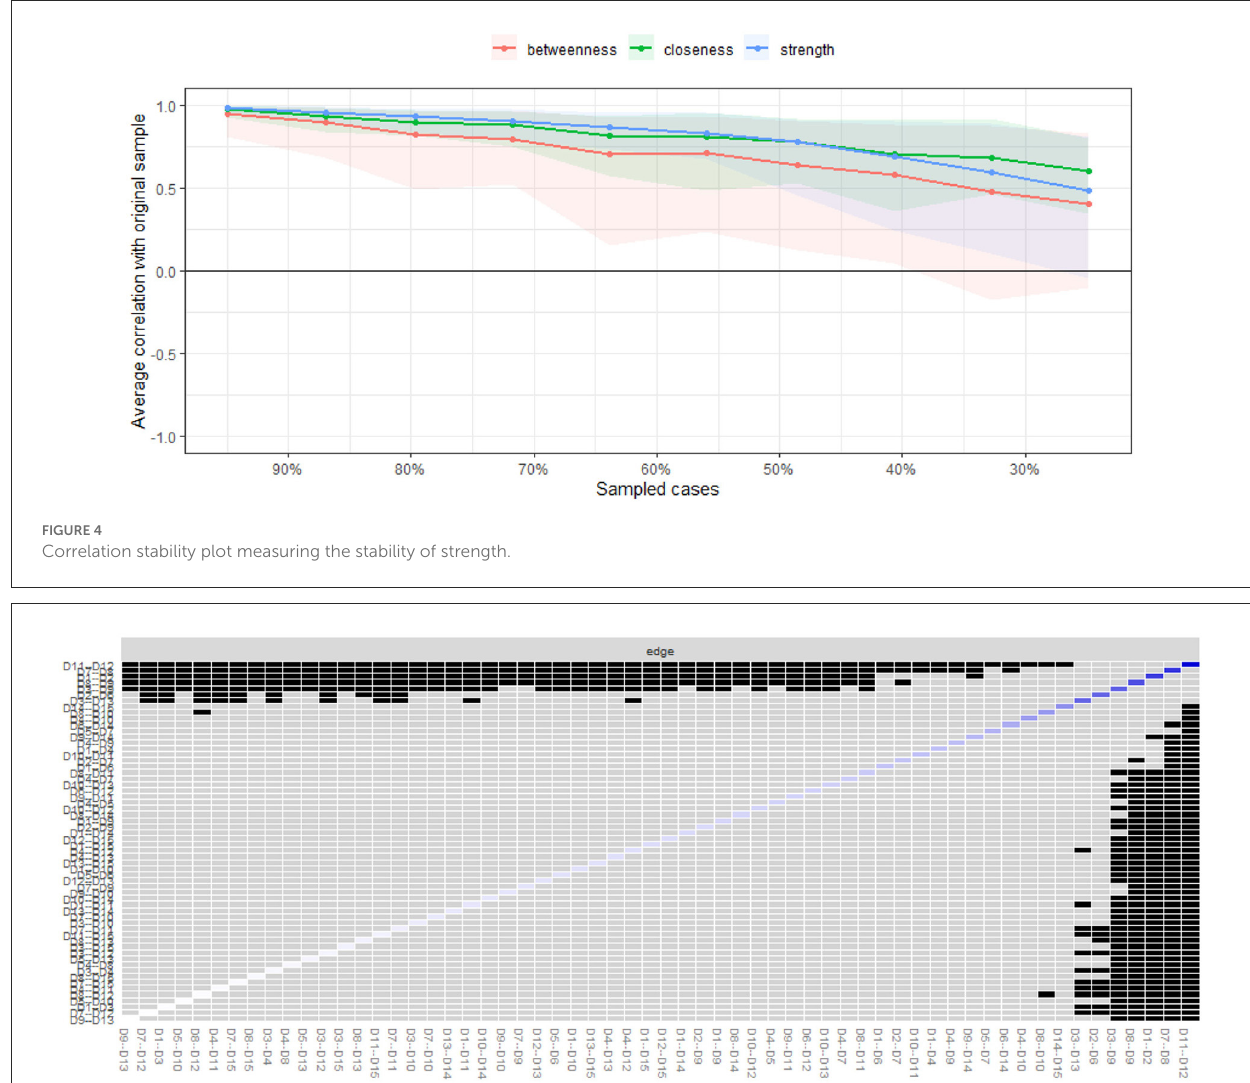
FIGURE5 Bootstrapped difference test for edge